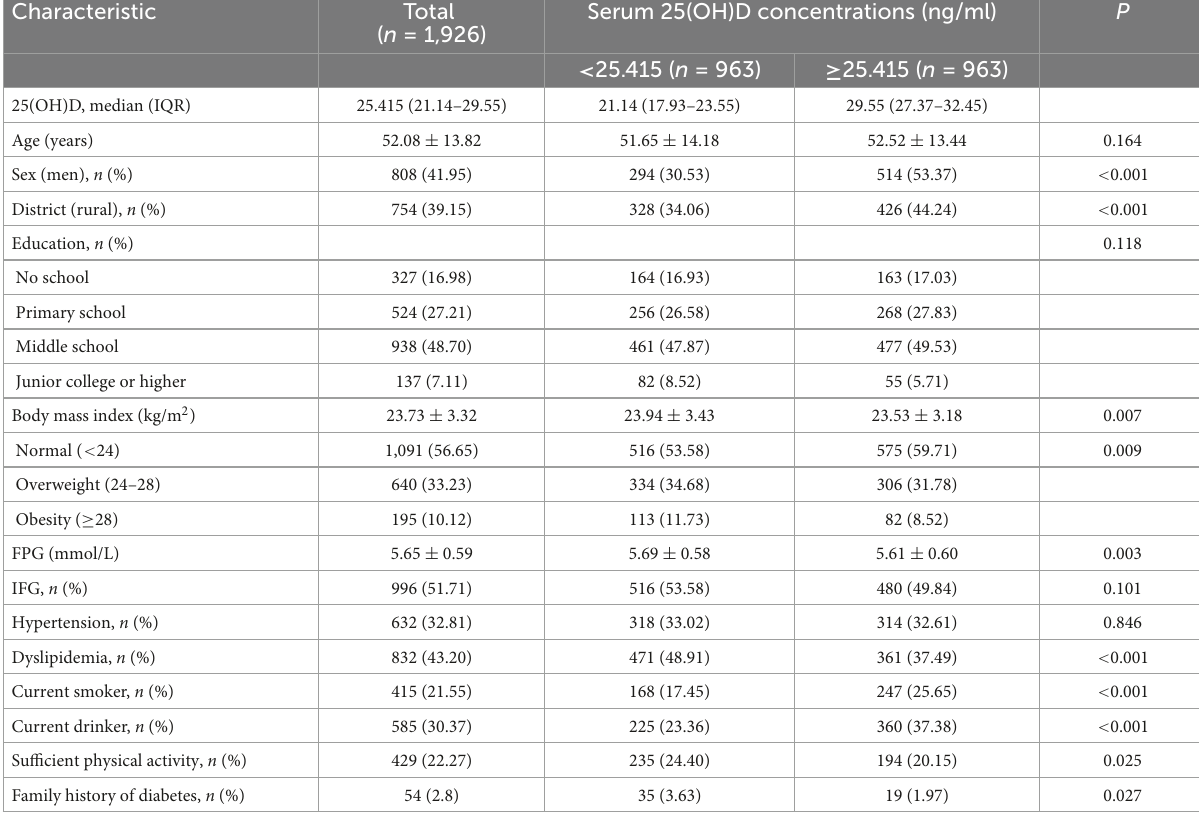
TABLE 1 Baseline characteristics of the study population according to serum 25(OH)D concentrations ( n = 1,926).